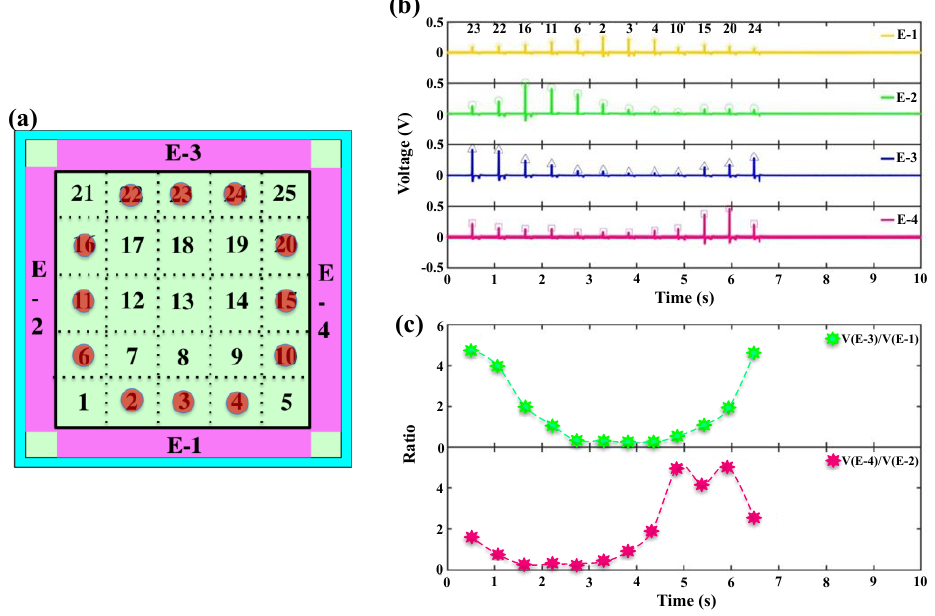
Figure 6. ( a ) Schematic illustration of the twelve tested points forming a circle in the direction from No. 23 to No. 24. ( b ) The output voltages and ( c ) the ratios of the twelve continuous touche.